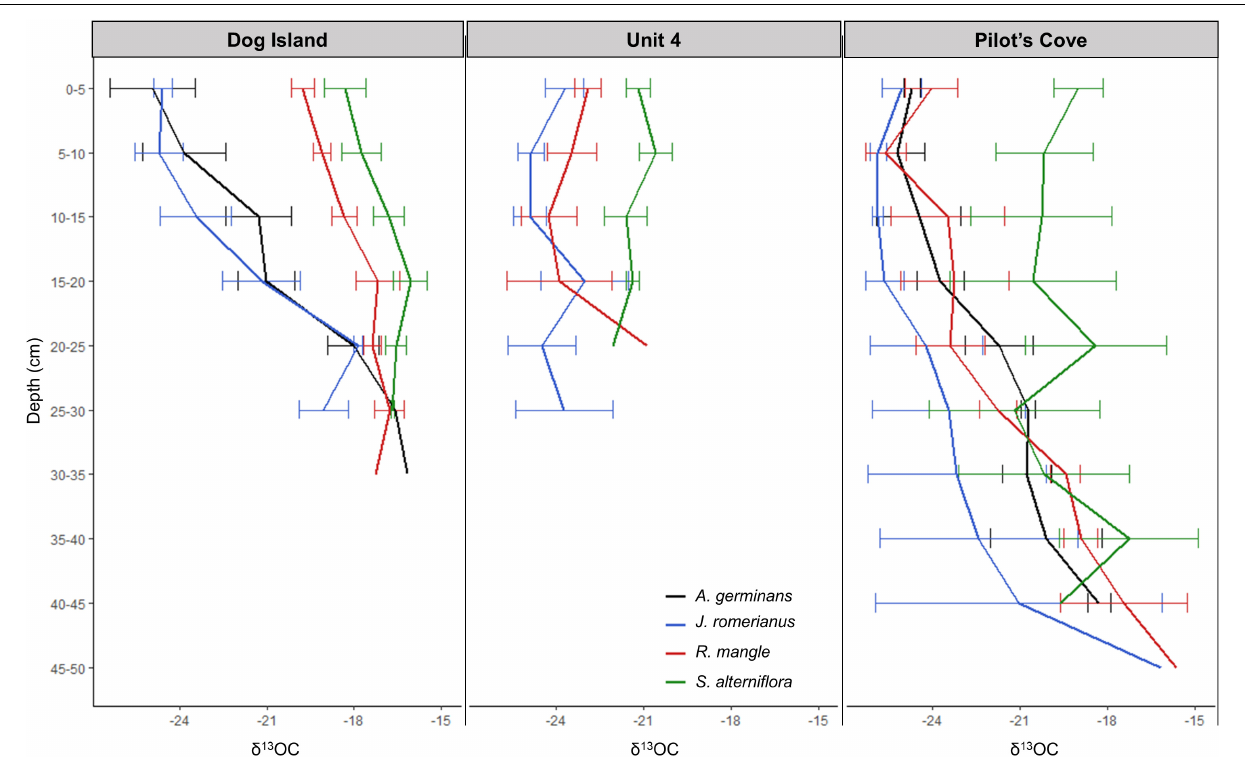
) values, plotted by depth (in 5 cm intervals) and vegetation type (denoted by color) at each (cid:104)